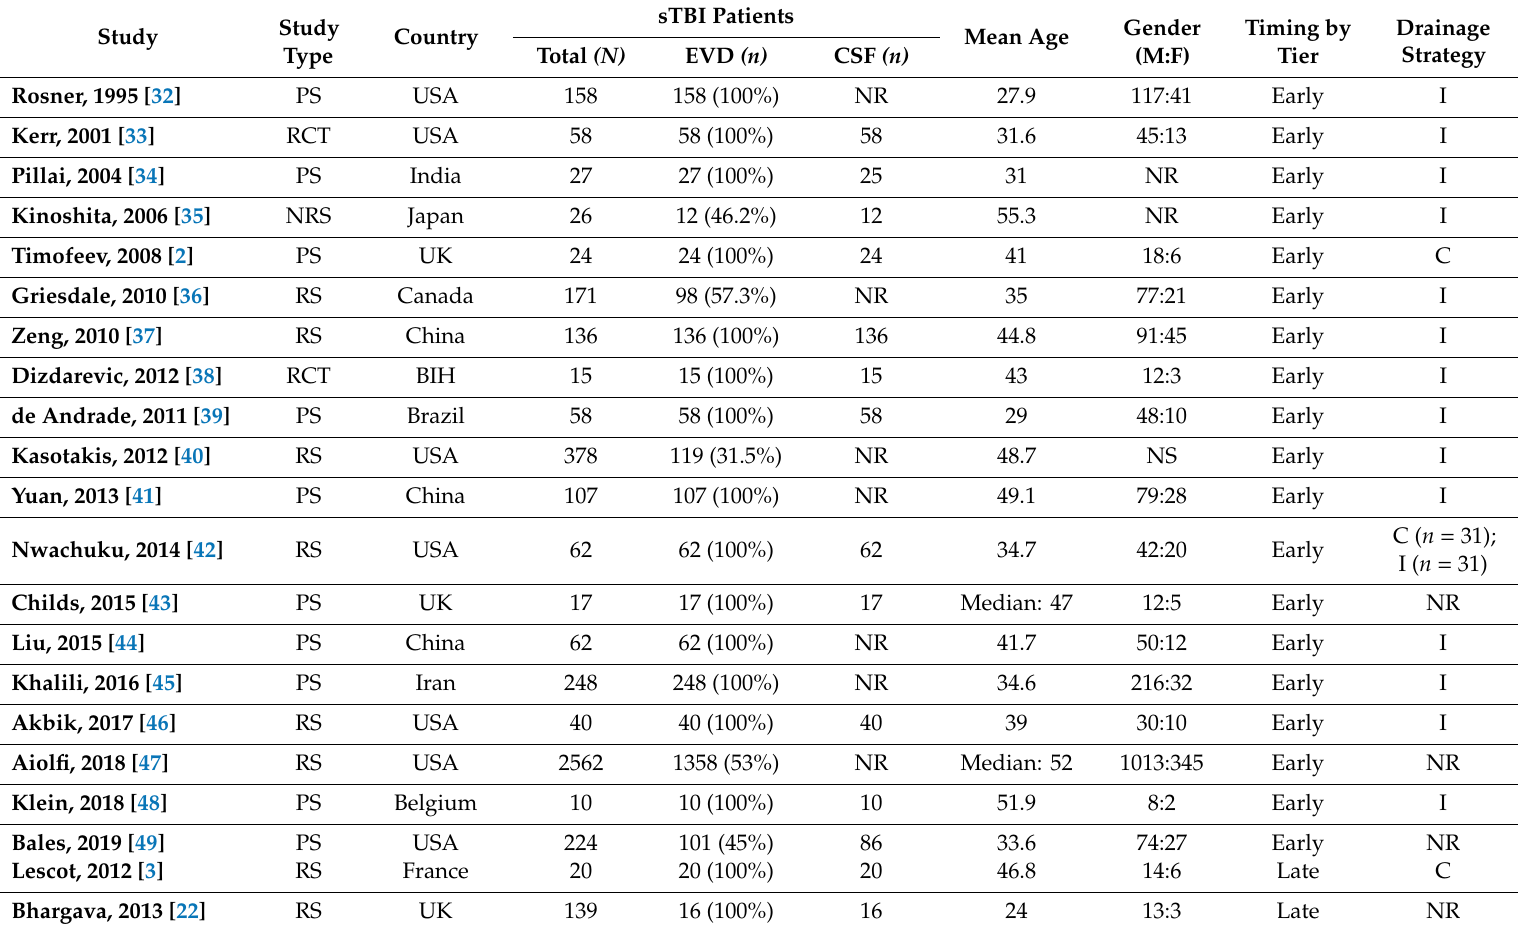
Table 2. Characteristics of the included